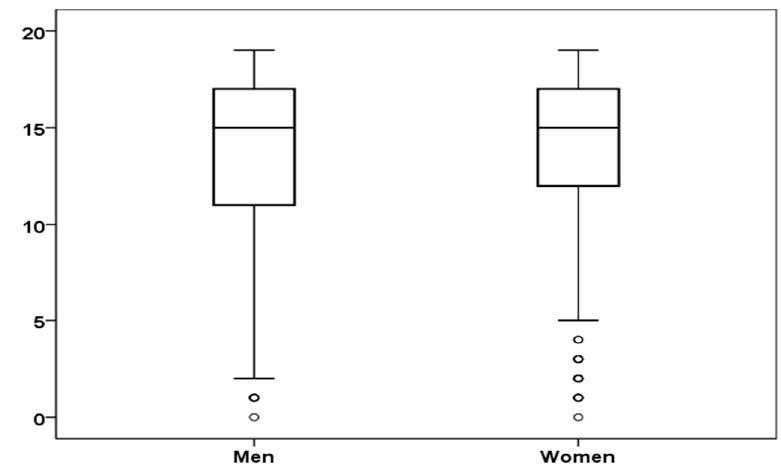
Figure 2. Boxplot of job satisfaction scores for men and women.